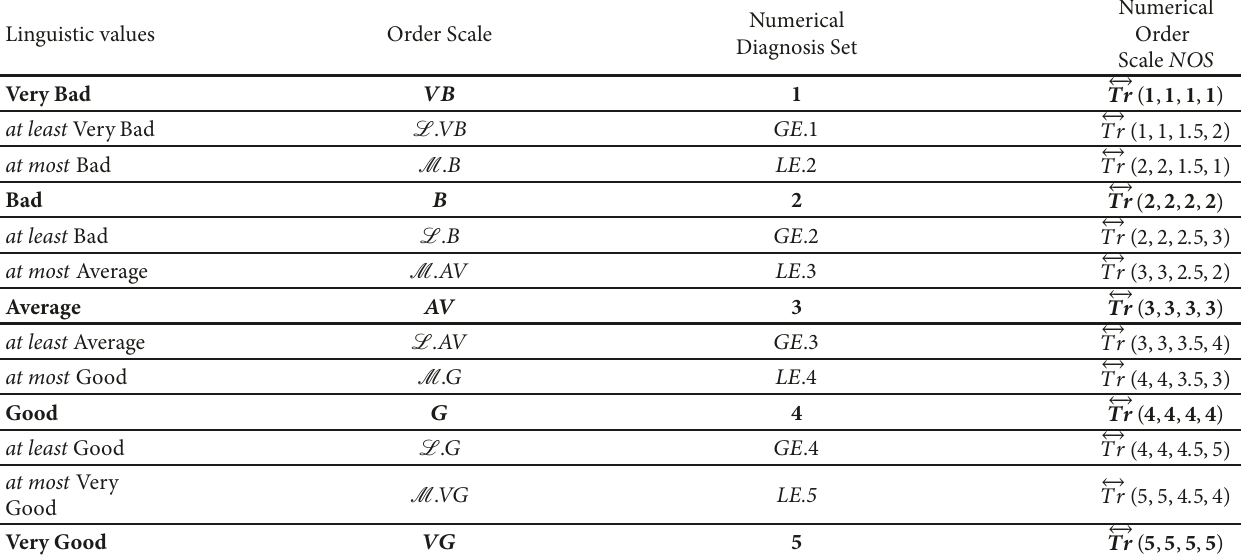
Table 1: Transformation of linguistic values into numerical order scale ∗ 𝑁𝑂𝑆